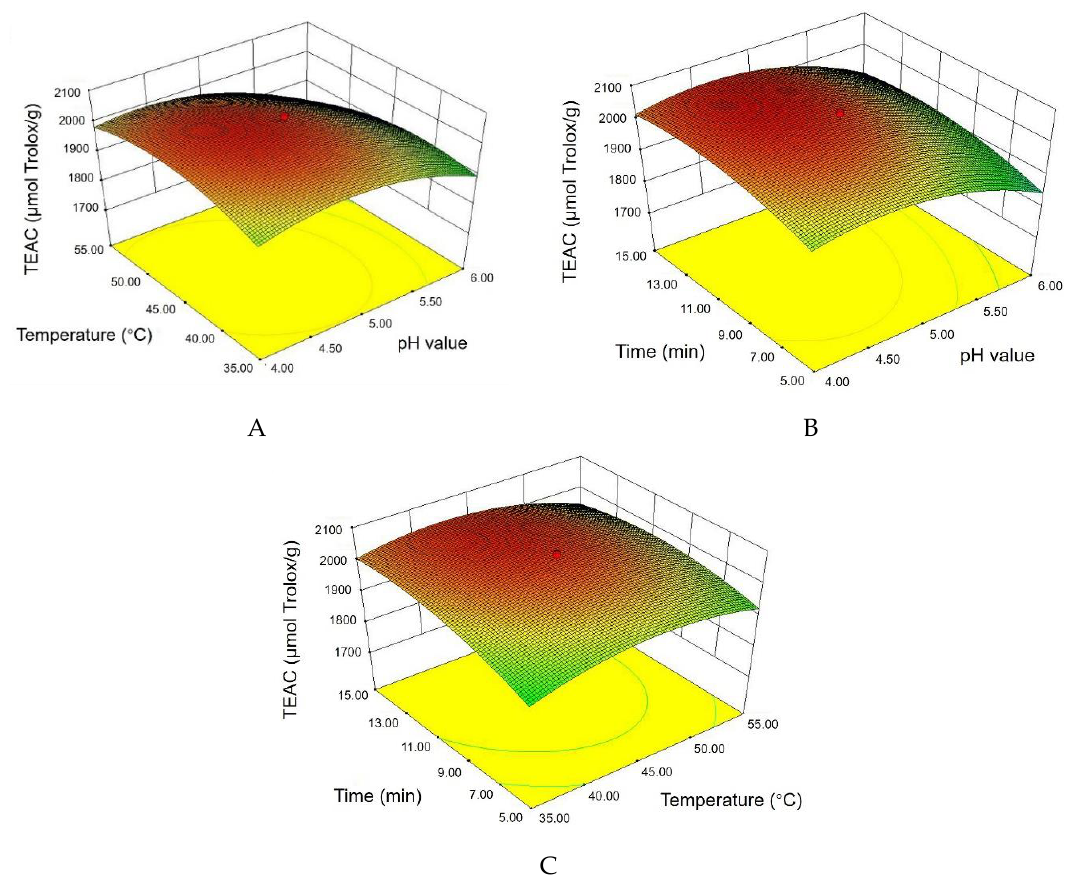
Figure 2. Graphical analysis of interactive effects on TEAC values. ( A ) the pH value of buffer solution and ultrasonic temperature; ( B ) the pH value of buffer solution and ultrasonic time; ( C ) ultrasonic temperature and time.